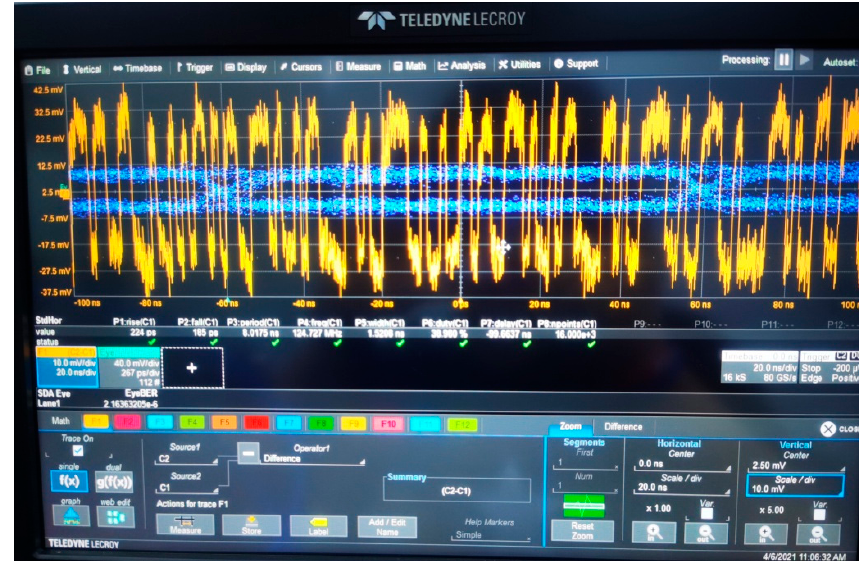
Figure 7. The eye diagram of experimental site at 8G communication frequency.